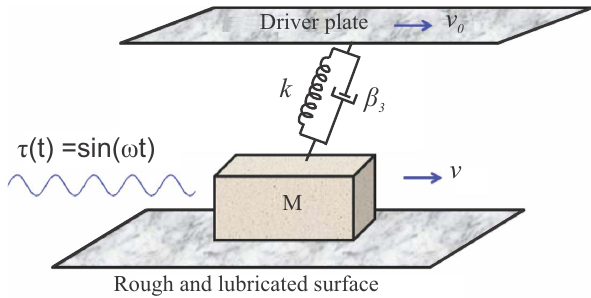
Figure 2. Dieterich–Ruina–Stribeck one-degree-of-freedom oscil- lator. Here, v 0 is a reference velocity, v is the block velocity, k is the constant of deformation, and β 3 is the dynamical viscosity co- efficient; τ(t) is an external and perturbing force with angular fre- quency ω